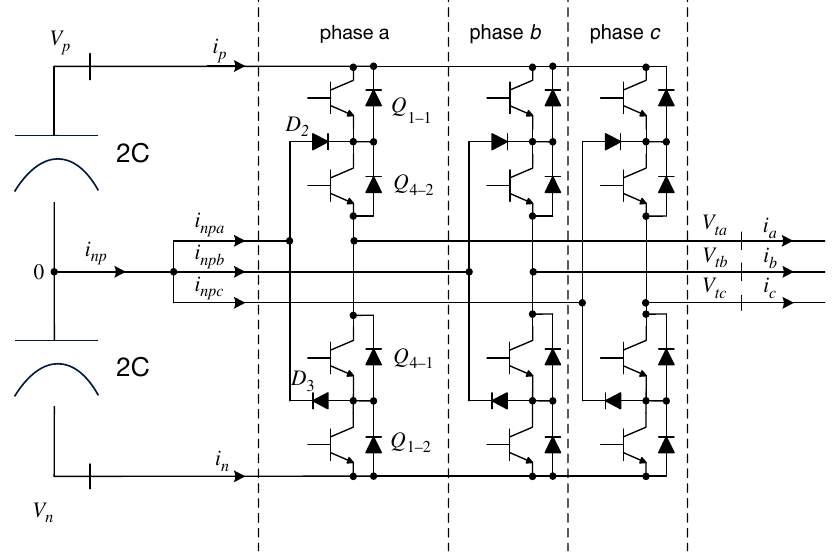
FIGURE 6.6 Schematic diagram of a three-level NPC. Figure 2. Schematic diagram of the three-level NPC converter